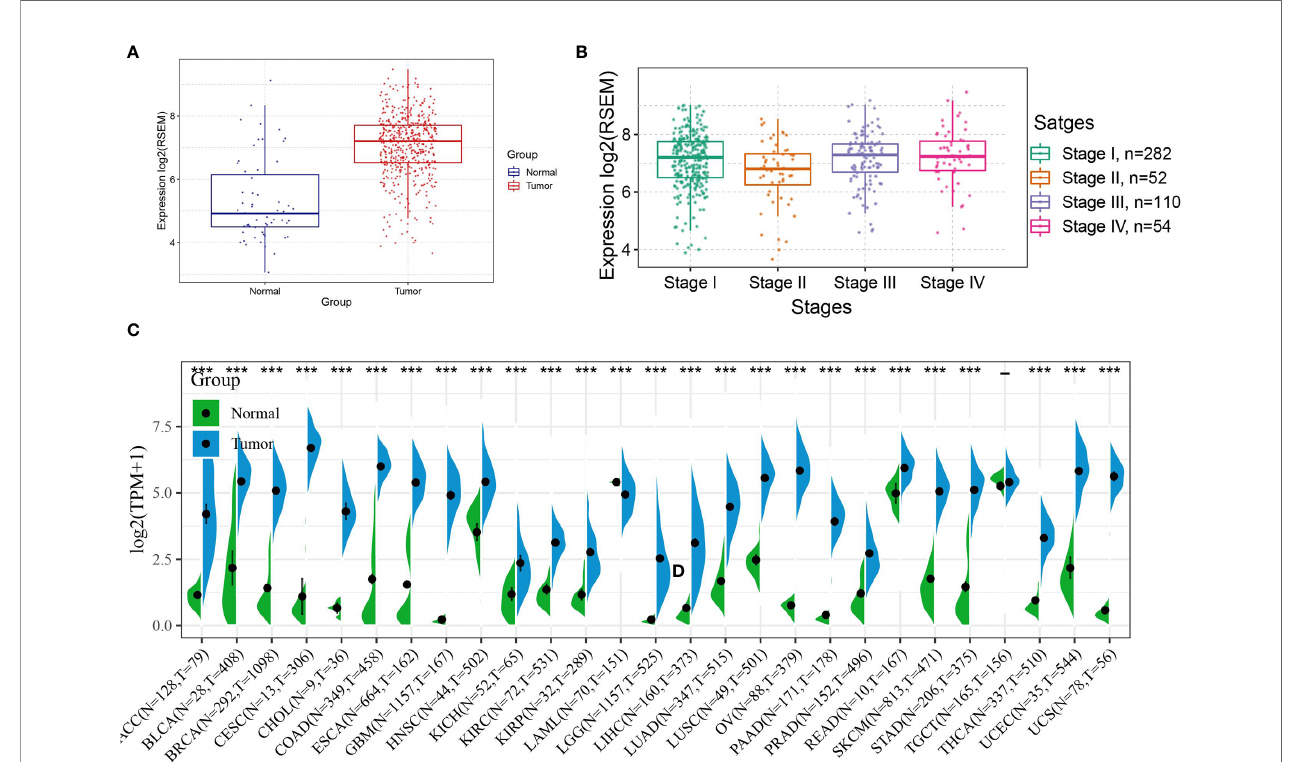
FIGURE 3 | Expression of ASF1B in tumors; (A) Expression level of ASF1B in THCA; (B) Expression level of ASF1B in different TNM stages of THCA; (C) Expression level of ASF1B in 27 cancer type. In (A) *** is P <